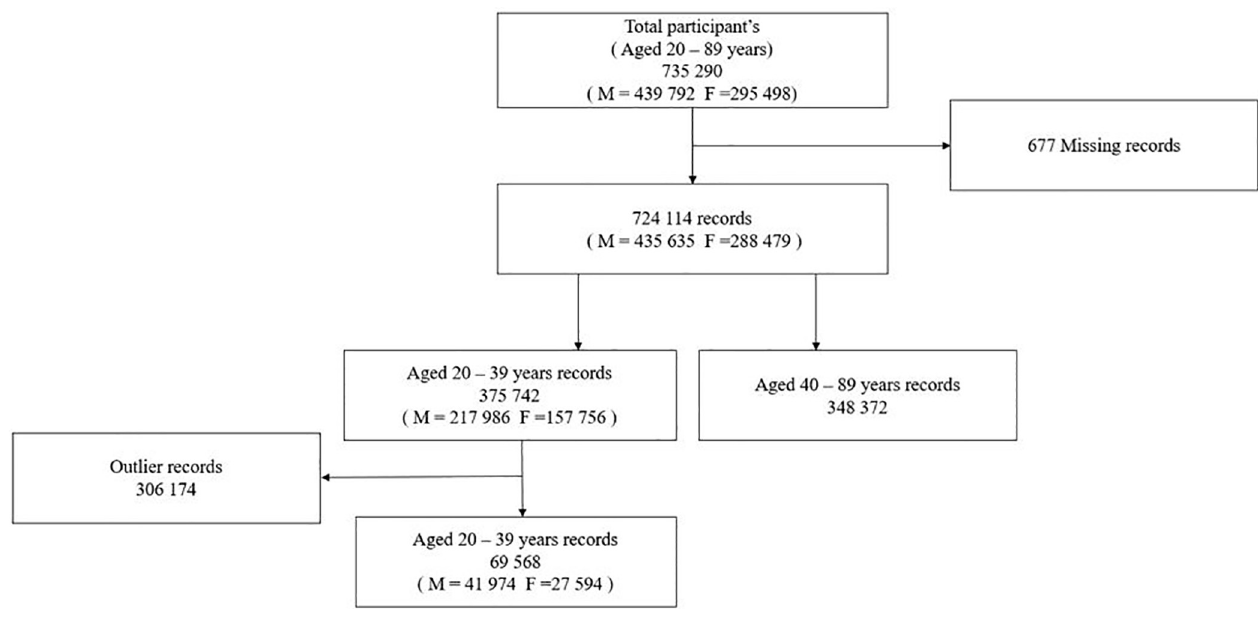
Fig 1. Study flow